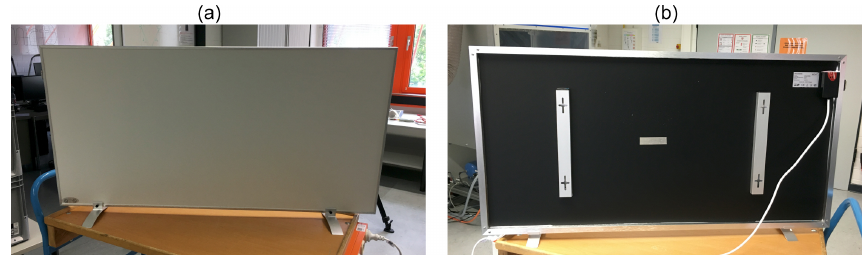
Figure 5. Visual images of the infrared radiator experiment with front (a) and rear (b) panels.